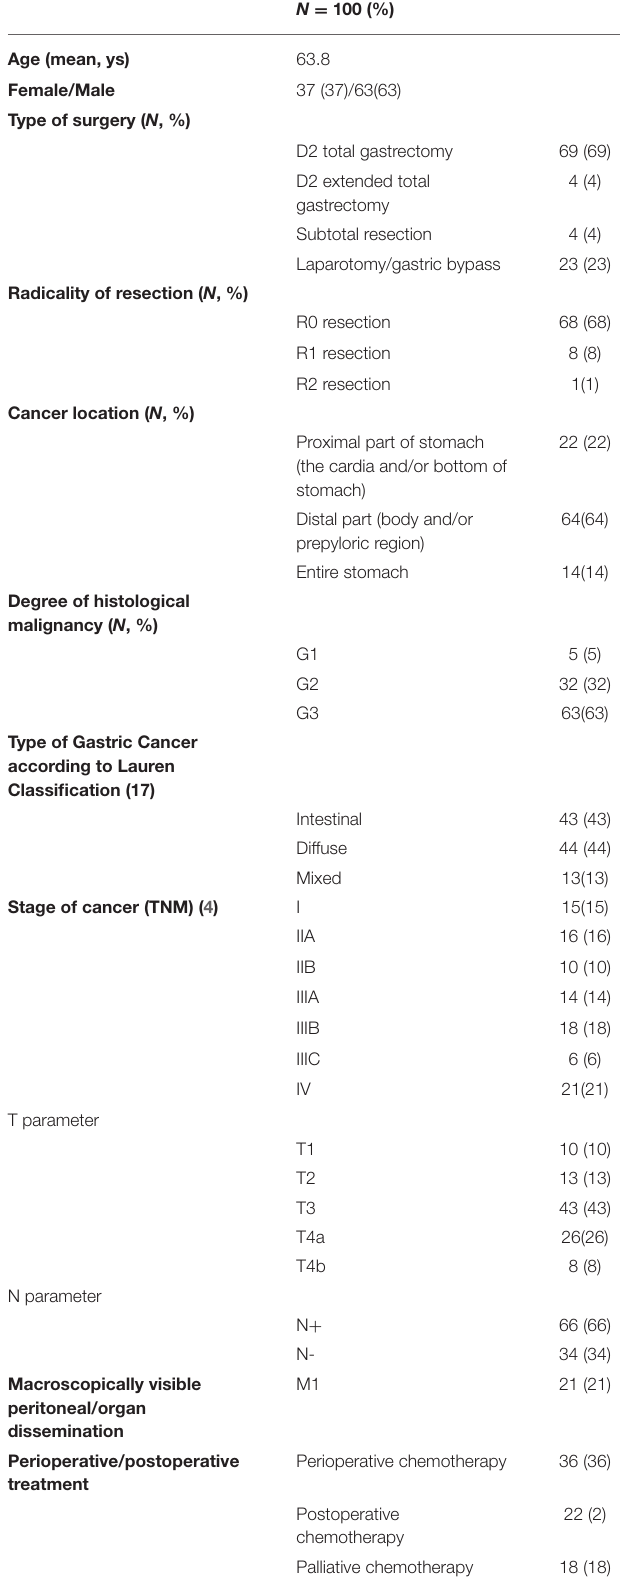
TABLE 1 | Clinical and histopathological characteristics of the study